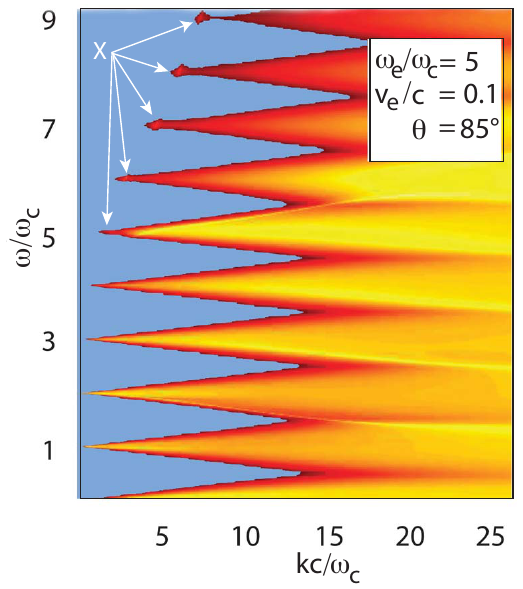
Figure 1. The thermal spectral densities of electromagnetic waves in a magnetized plasma for nearly perpendicular propagation (af- ter Yoon and López, 2017) for an electron plasma-to-cyclotron fre- quency ratio of ω e /ω c = 5. The thermal level is structured by the electromagnetic electron cyclotron harmonics (Bernstein modes). The red intensified spots in the thermal noise starting at (cid:96) = 5 are located along a parabola of rising frequency, which is the free-space branch of the X mode in combination with the electromagnetic Bernstein modes. They may serve as cyclotron harmonic seed elec- tromagnetic fluctuations for the X mode, which, when becoming amplified by the ECMI, can propagate and escape from the